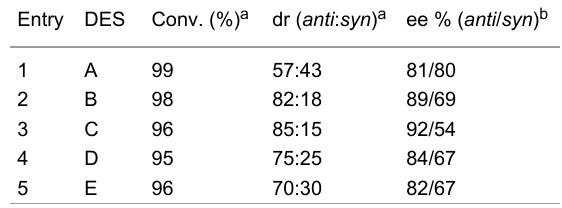
Table 2: DES screening for the proline-catalyzed in batch aldol reac- tion. Entry